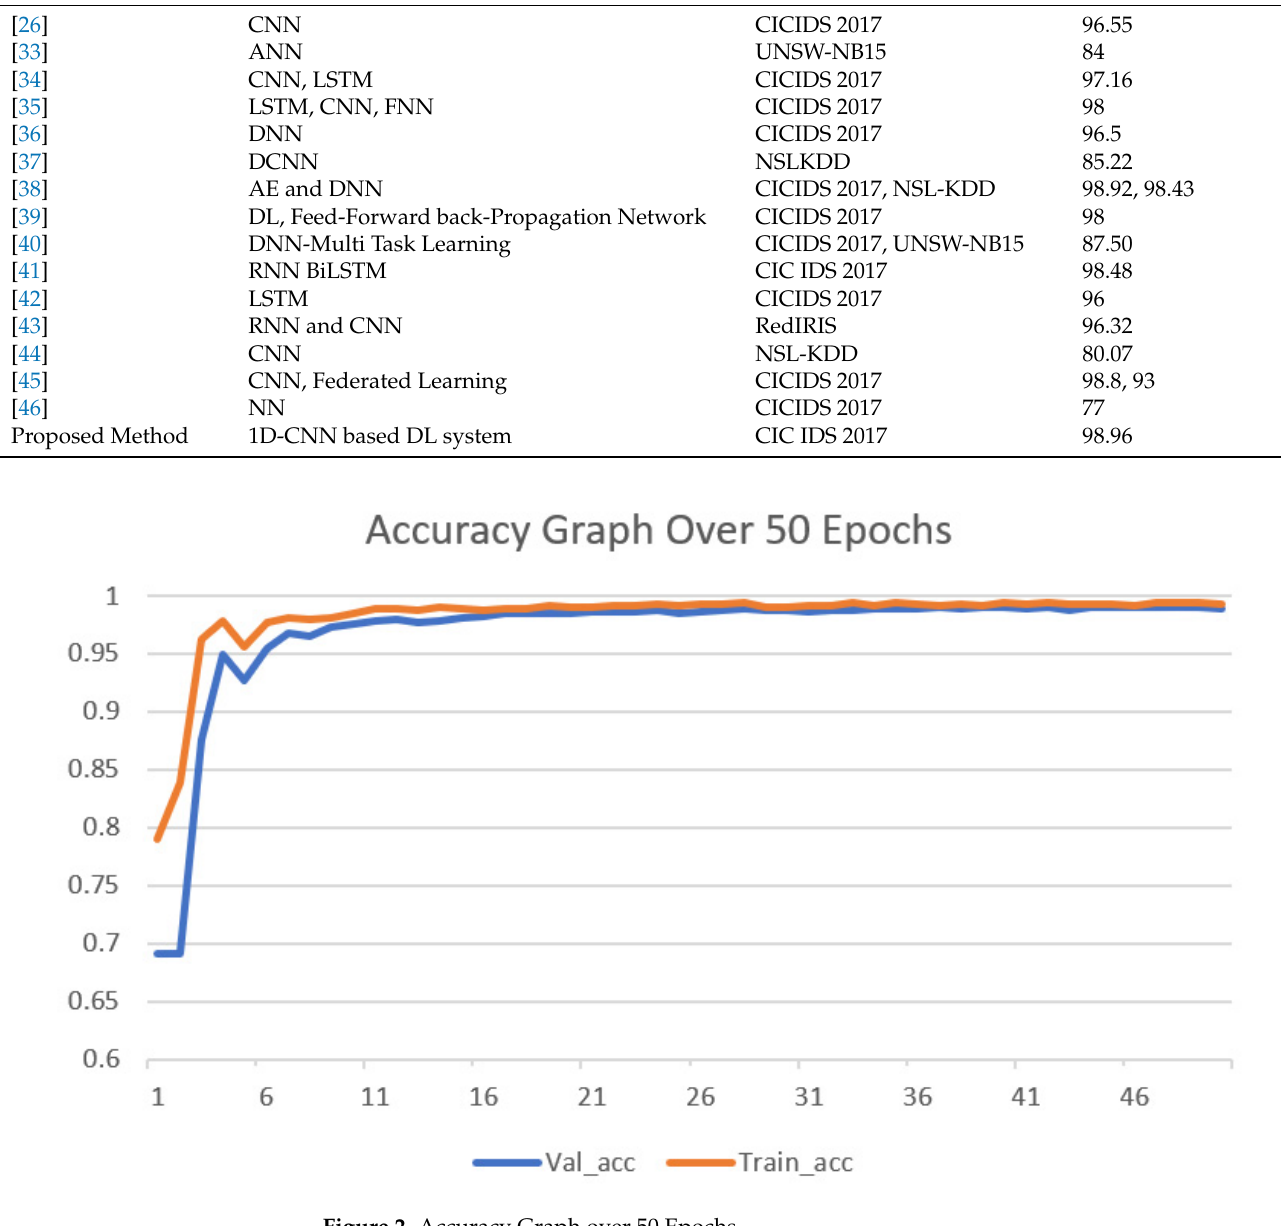
Figure 2. Accuracy Graph over 50 Epochs.